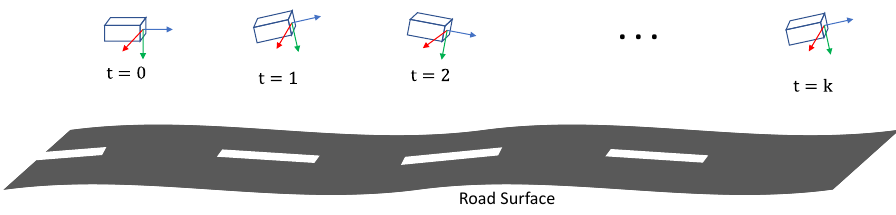
Figure 1. Illustration of a typical dynamic motion of a front-facing camera on a moving vehicle. The pitch angle (rotation around the x -axis) is actually oscillating with an amplitude of about 1 ◦ , though the vehicle moves straight and the road surface looks flat enough. Such pitch angle oscillation is amplified when the vehicle encounters imperfect road surfaces and speed bumps.